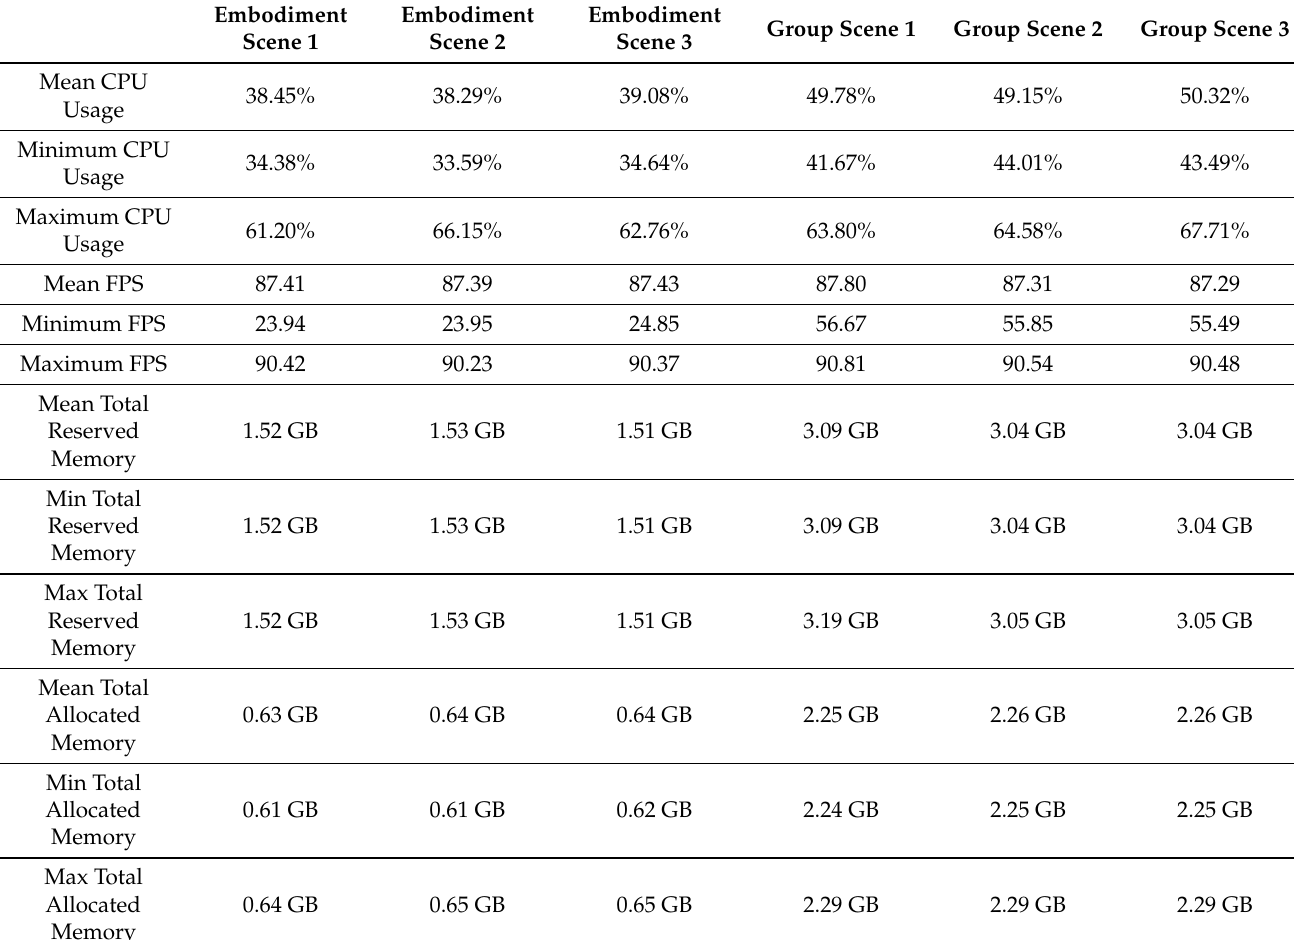
Table A3. Results for Test Condition 2: NeuLog sensors.